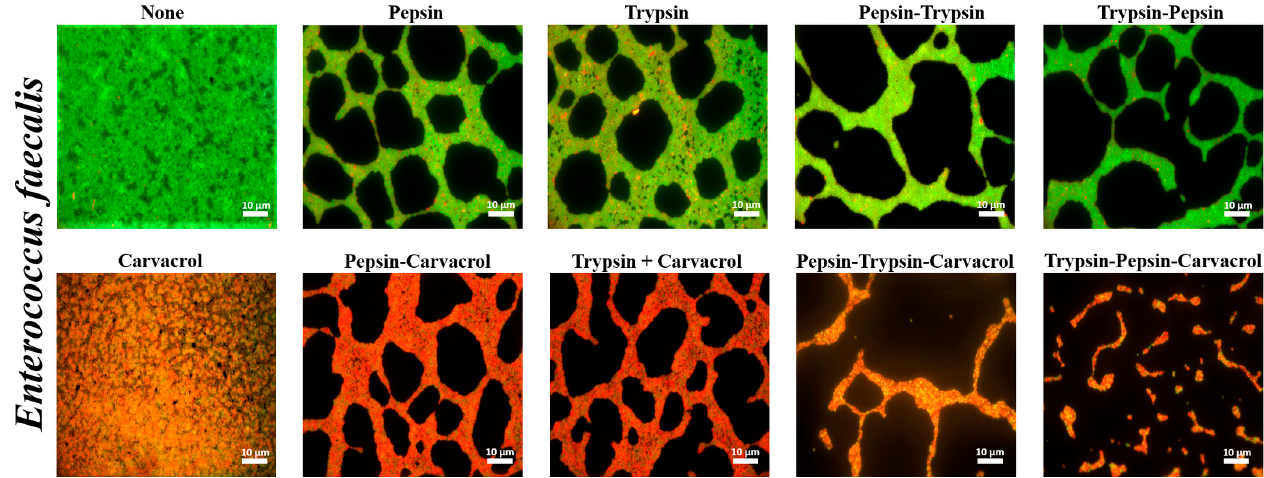
Figure 7. Epifluorescence microscopic images of E. faecalis biofilms after treatment with pepsin, trypsin, or sequential treatment of both at a concentration of 1 mg mL − 1 for 1 h each, or followed by treatment with carvacrol at ½ MIC (0.312 mg mL − 1 ) for 5 min. Cells were visualized after staining with SYTO9 (green fluorescence for living bacteria) and propidium iodide (red fluorescence for dead bacteria). Control represents biofilm treated with tryptone salt broth.